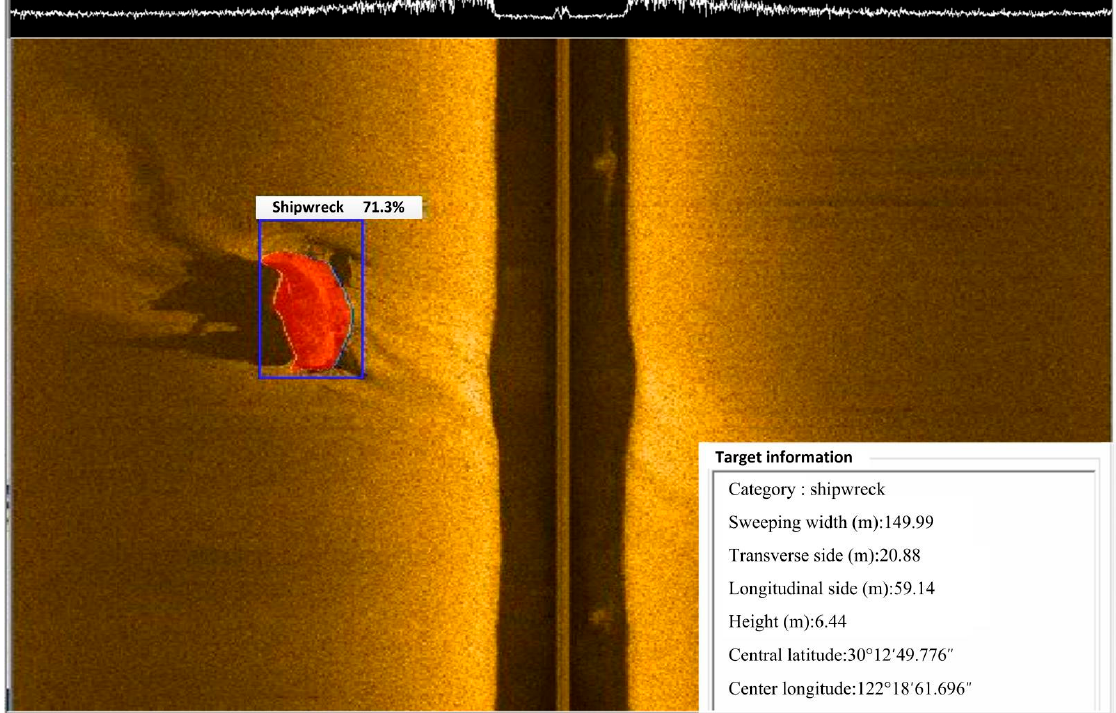
Figure 16. Key information transmission for the shipwreck target.